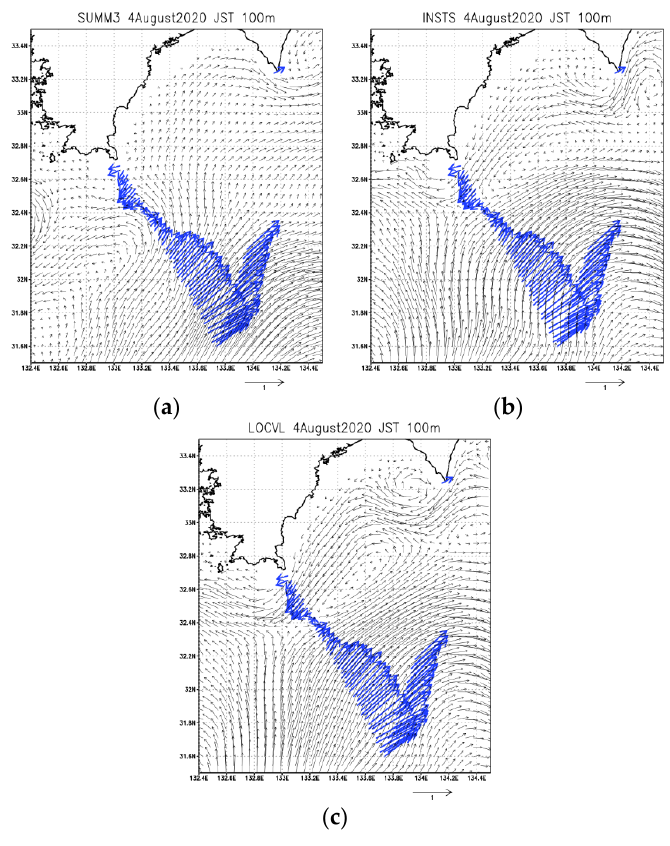
Figure 16. Daily mean modeled current at 100 m depth of three cases (black vectors) on 4 August 2020 JST. ( a ) SUMM3, ( b ) INSTS, and ( c ) LOCVL. Blue color vectors denote the observed current obtained by the research vessel Tosa Kaiyou Maru on 4 August 2020 JST.